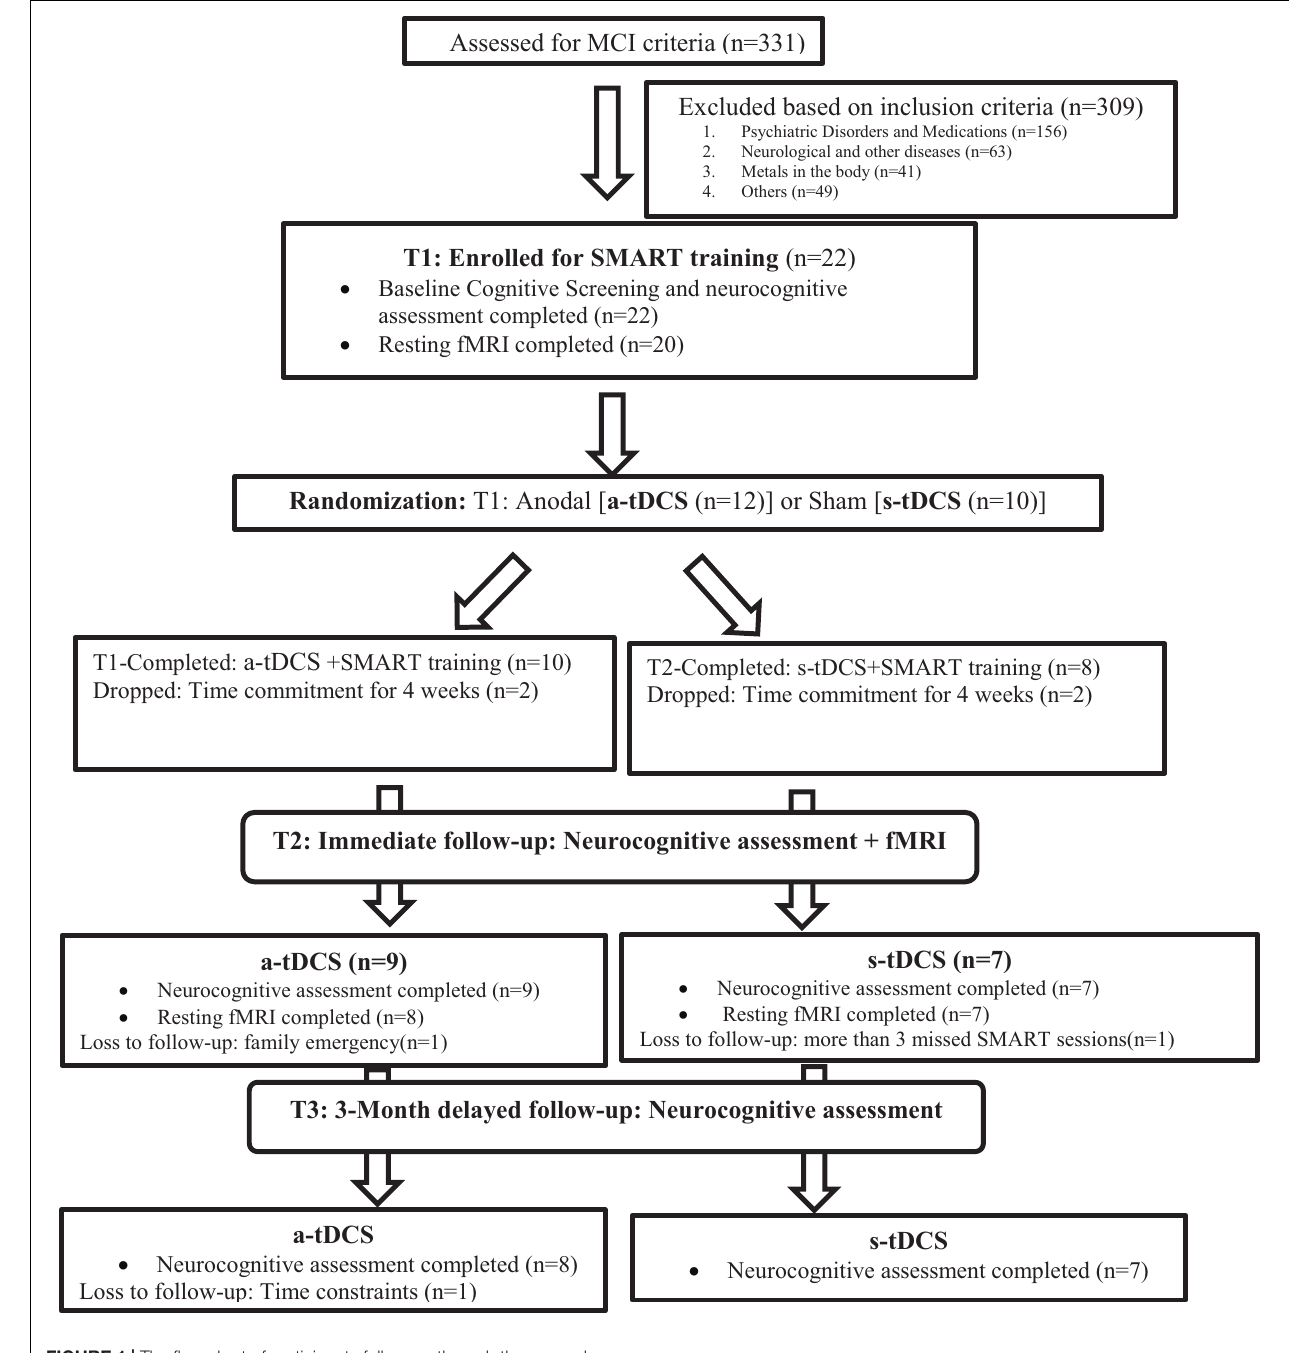
s-tDCS stimulation immediately prior to each of the SMART training